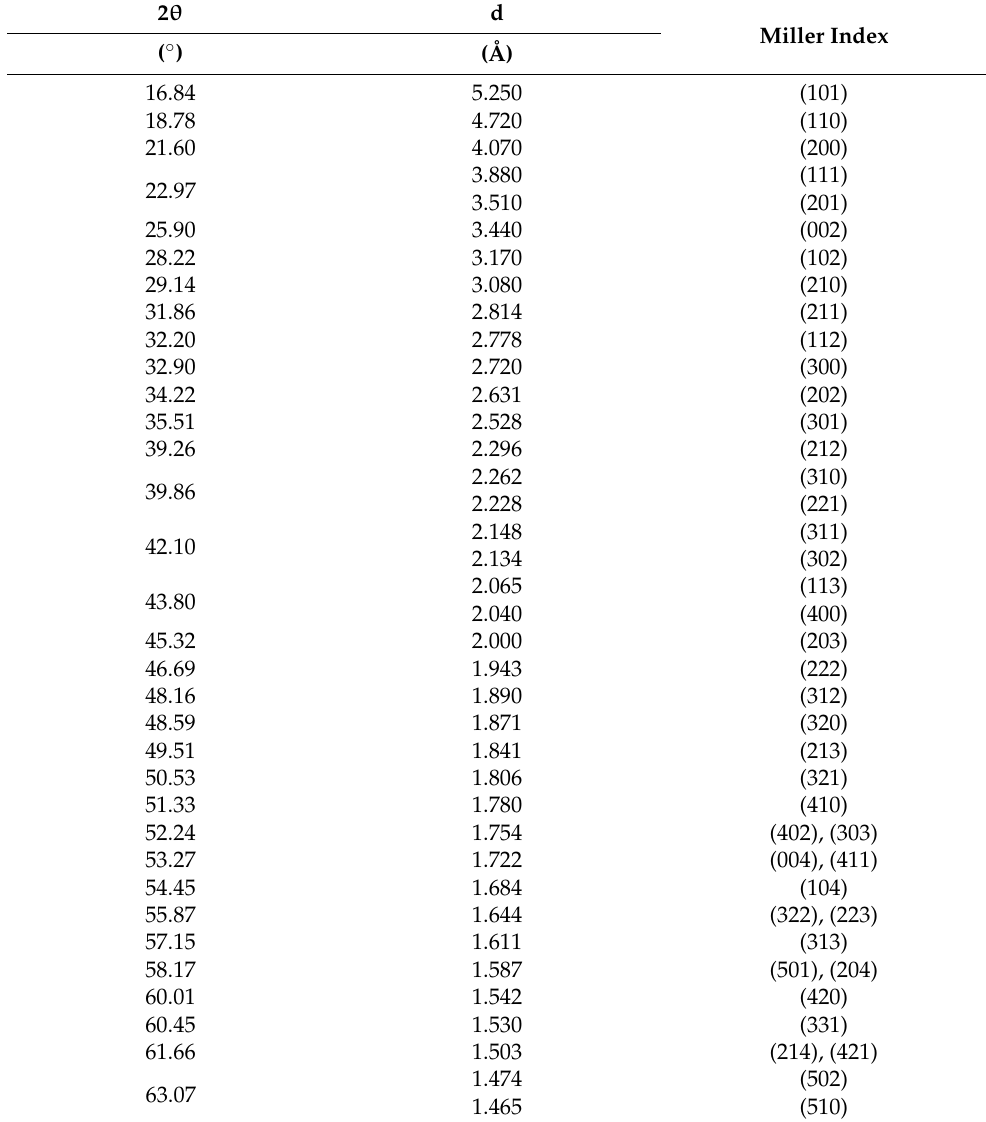
Table 3. List of peaks observed in the XRD pattern of HAP. Reproduced with permission from [10], Wiley Online Library,